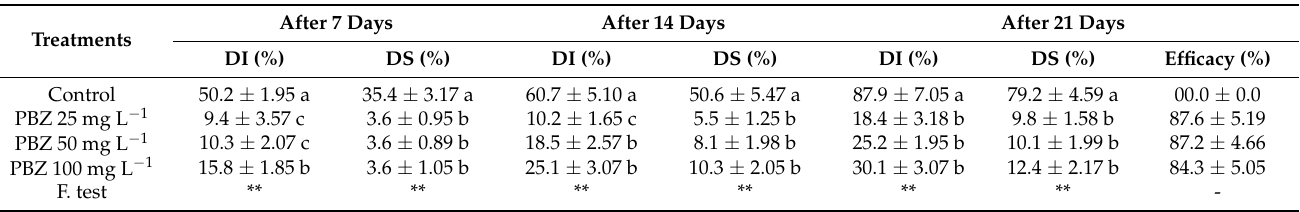
Table 3. Effect of PBZ applications on both disease incidence (DI) and disease severity (DS); % of tomato early blight pathogen ( A. solani ) under greenhouse conditions at 7, 14, and 21 dpi and an efficacy % at 21